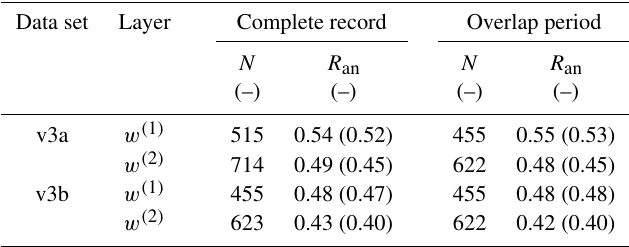
Figure 4. Difference in quality between the v3 and v2 data sets of surface soil moisture ( R( GLEAM v3 , in situ ) − R( GLEAM v2 , in situ ) ). Colours relate to the difference in correlations against in situ measurements for the v3 and v2 surface soil moisture data sets. Statistics are calculated based on all available sites reporting measurements falling within the spatio-temporal domain of the different data sets. Maps on the right show a detailed overview of the results for the CONUS. Table 3. Average anomaly correlations for different soil moisture data sets (v3a and v3b) and for the first two model layers ( w ( 1 ) and w ( 2 ) ) against in situ measurements: R an is the anomaly correlation and N is the number of sites included in the sample. The first part of the table reports the averaged statistics over all available sites and the entire study period, while the second part shows the same statistics for a common sample of sites, and an overlapping study period (2004–2015) for the two data sets. The same statistics for the data sets produced using GLEAM v2 are reported between